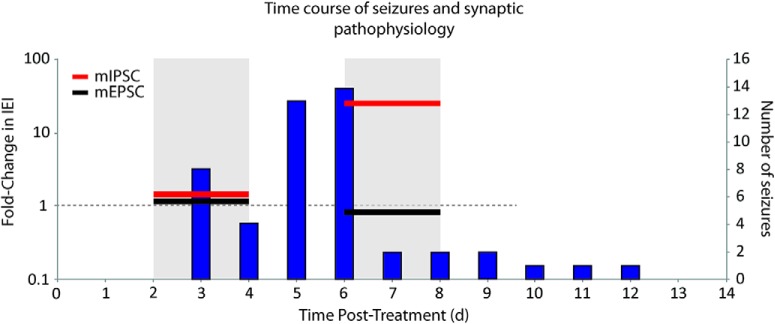
Comparison of the time course of seizures with synaptic pathophysiology. Seizure frequency (i.e., number of seizures per day, right axis) for all mice is plotted (vertical bars) in reference to the fold change in interevent intervals (IEIs, horizontal bars, left axis) of the mIPSCs (red) and mEPSCs (black) recorded from pyramidal cells, in separate cohorts of mice, during the time periods of days 2-4 and days 6-8 after DT treatment. Fold change in IEI was calculated as the ratio of ablated to control so that an increase in fold change indicates a longer interval between events (and therefore lower frequency) in the ablated mice. The occurrence of SRSs is concurrent with the decrease in mIPSC frequency (i.e., the increase in mIPSC IEI). The fold change in IEI of the mEPSCs remains close to 1 at both time periods, demonstrating no concomitant change in excitatory synapses on to pyramidal cells over these time periods.